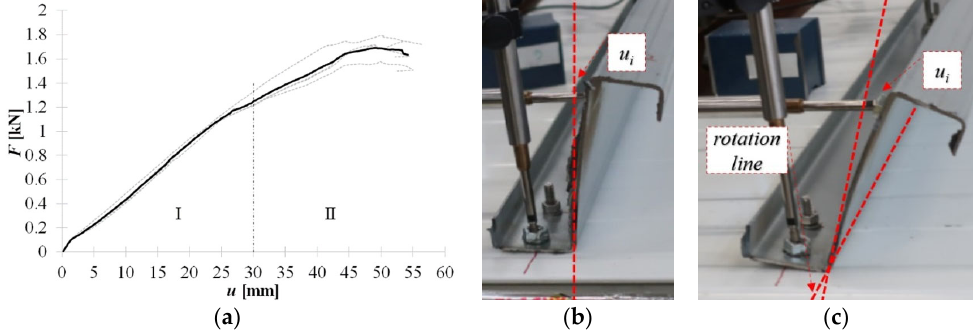
Figure 10. Self ‐ drilling fasteners (F): ( a ) equilibrium load ‐ displacement paths, ( b ) initial (up to 0.05 kN) response, ( c ) linear response (stage I).